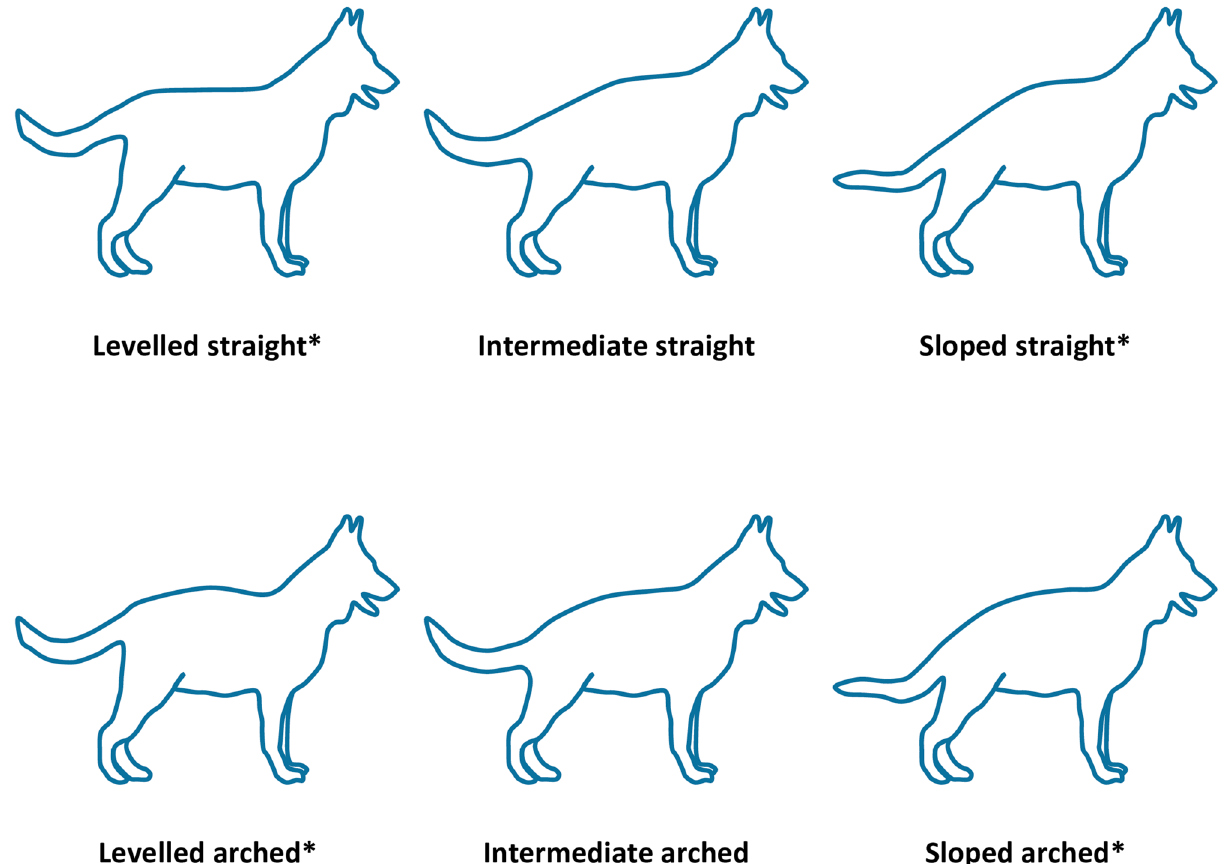
Figure 4. Schematic illustration of the GSD back profiles: straight and arched curvatures; and: levelled, intermediate and sloped inclinations. *Modified from Fischer and Lilje 2 and Winfrow 4